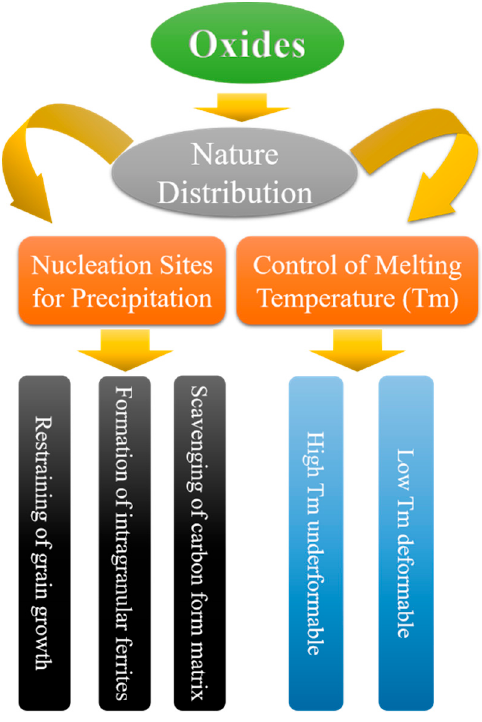
Figure 1. Concept of oxide metallurgy [12].